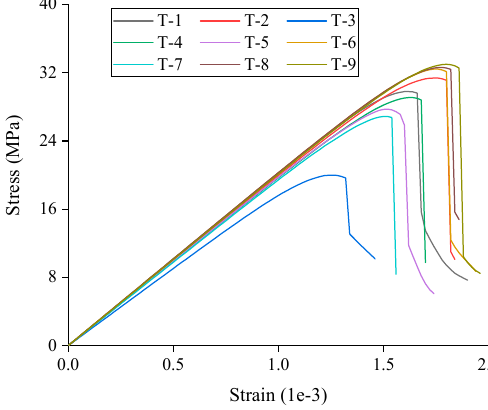
Figure 4. Stress–strain curves of the numerical models.